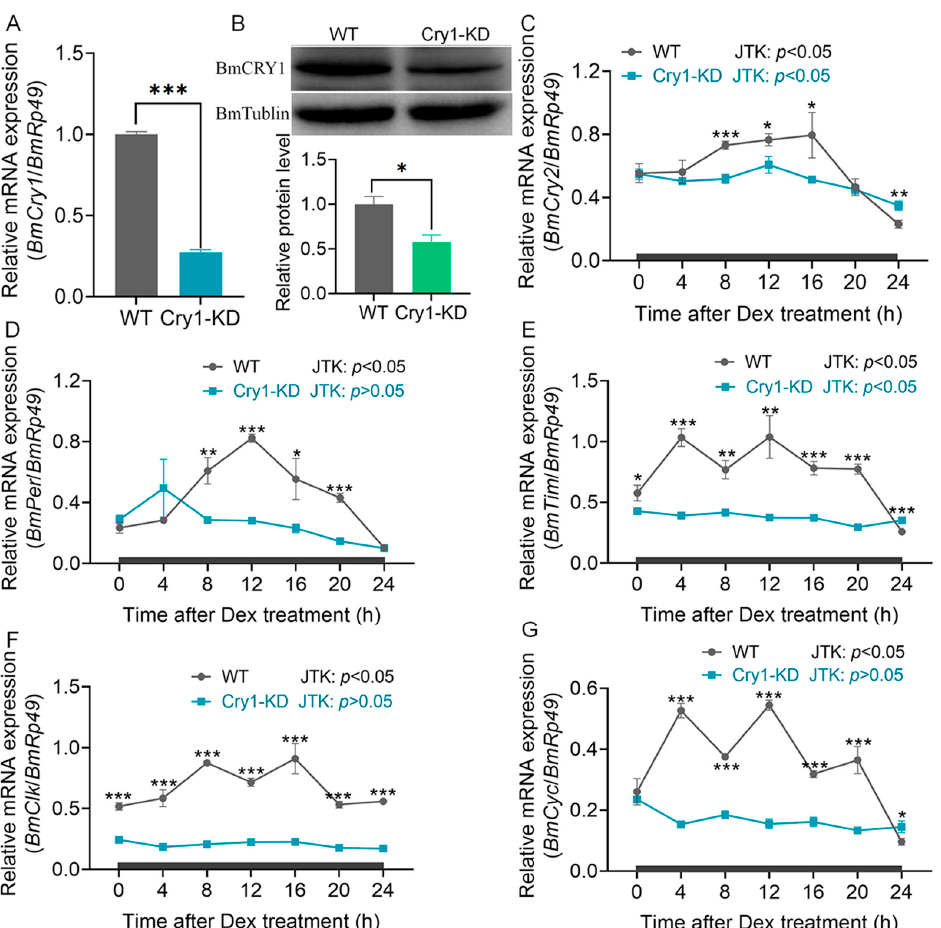
Figure 1. BmCry1 knockdown efficiency and clock gene expression. ( A ) BmCry1 transcripts were analyzed by qRT-PCR with BmRp49 as the internal control ( n = 3). ( B ) BmCRY1 protein levels with BmTUBLIN protein as the internal control ( n = 2). ( C – G ) Transcripts of the five clock genes were analyzed with qRT-PCR using BmRp49 as the internal control ( n = 3). Cry1-KD and WT cells were cultured at 26 °C in DD. The cells were treated with 100 μ M dexamethasone (DEX) for 2 h, and the transcripts of these genes were investigated. Samples were analyzed at 4 h intervals for 24 h. JTK: p < 0.05 indicated that the gene expression had a 24- h circadian rhythm, JTK: p > 0.05 indicated no 24 h circadian rhythm in gene expression. The black lines indicate constant darkness. WT, wild-type cells; Cry1-KD, BmCry1 knockdown cells. *, p ≤ 0.05; **, p ≤ 0.01; ***, p ≤ 0.001.